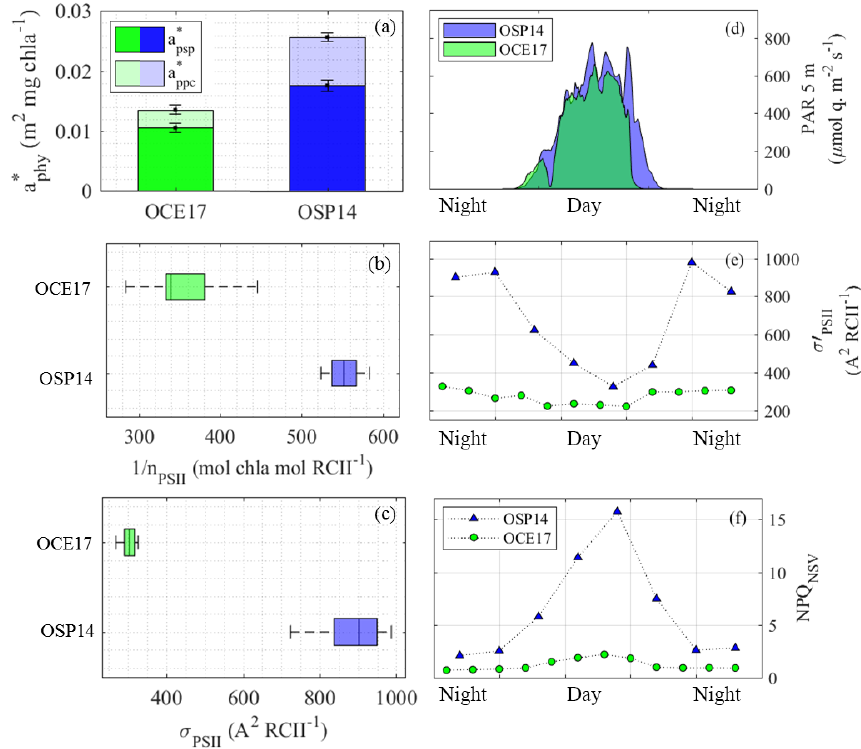
Figure 6. Comparison of light absorption characteristics at the OSP14 and OCE17 sampling sites. (a) The mean (400–700nm) Chl a -specific absorption coefficient of phytoplankton ( ˆ a ∗ , m 2 mgChl a − 1 ), showing contribution of absorption by photosynthetic pigment ( ˆ a ∗ psp ) phy